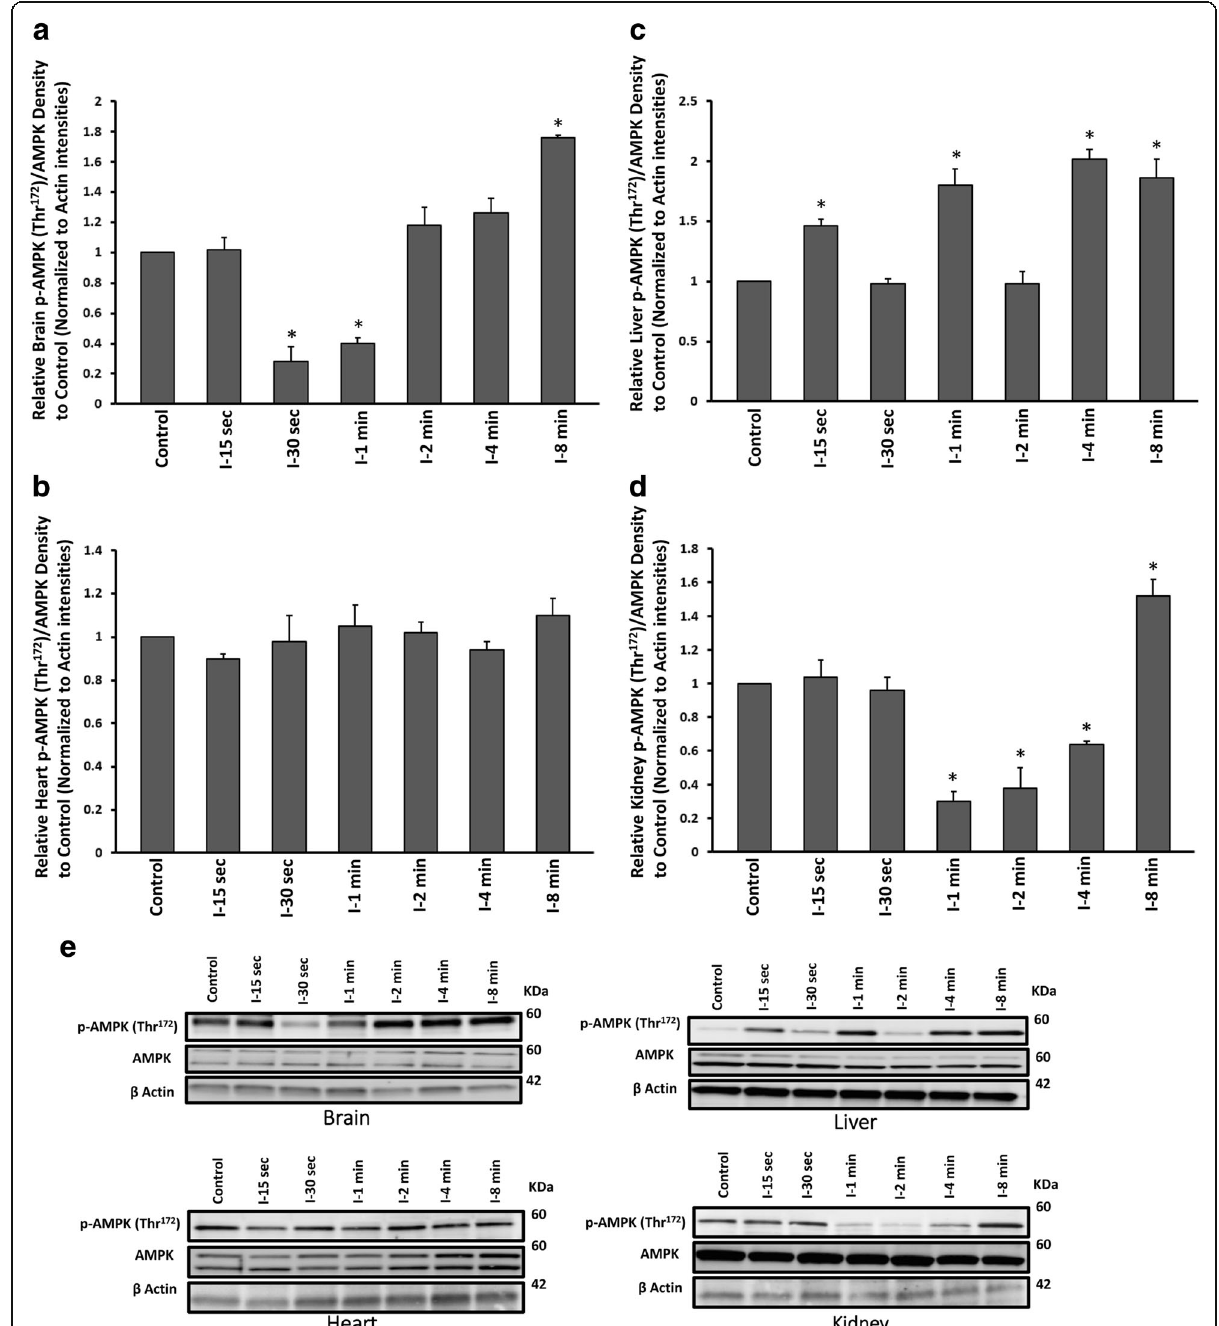
Fig. 4 Western blot analysis results of p-AMPK at Thr 172 and total protein of AMPK assessment from a brain b heart c liver and d kidney tissues of ischaemic and control groups. All values are expressed as percent change relative to control group and were corrected by the Actin level. e Protein band intensities of p-AMPK (Thr 172 ), AMPK and Actin. I-15 s: 15 s ischemia, I-30 s: 30 s ischemia, I-1 min: 1 min ischemia, I-2 min: 2 min ischemia, I-4 min: 4 min ischemia, I-8 min: 8 min ischemia * p <0.001 all groups vs control (One Way ANOVA, followed by post hoc Tukey ’ s). Error bars depict the